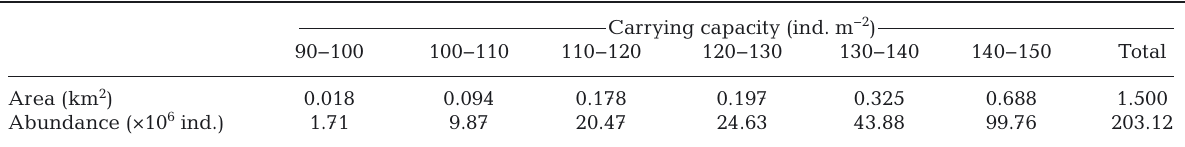
Table 4. Area covered (km 2 ) and Perinereis aibuhitensis abundance (×10 6 ind. per class) in 6 different classes of